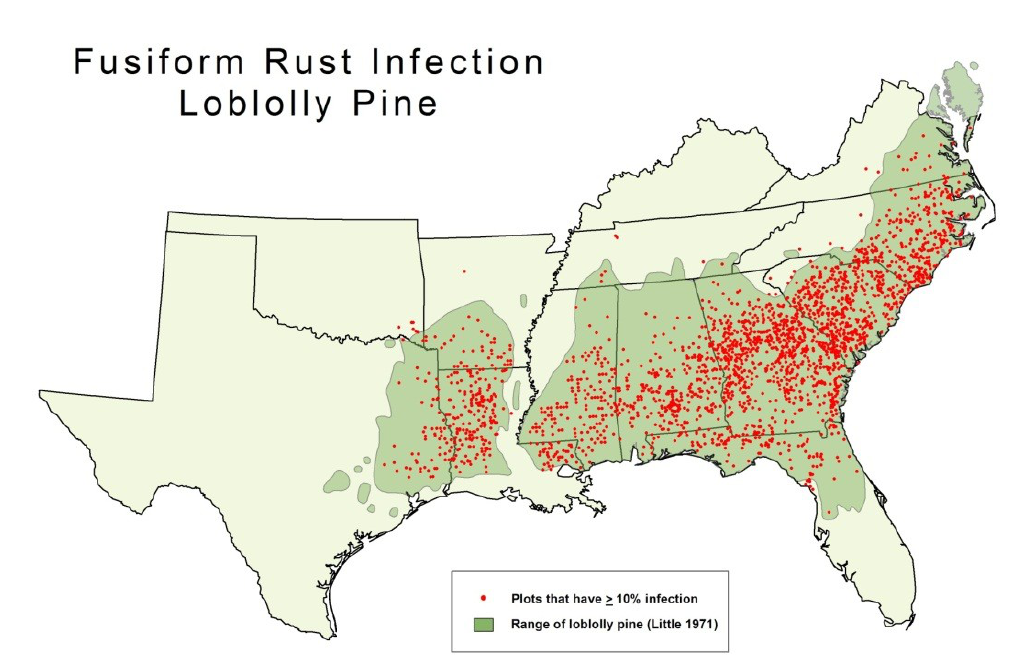
Figure 3. Locations of Forest Inventory and Analysis plots with the loblolly pine forest type and ≥10% fusiform rust infection on trees at least 1.0 inch in diameter at breast height. Estimates of infection are based on FIA inventories between 1987 and 1994. Reproduced from Starkey et al. [3].